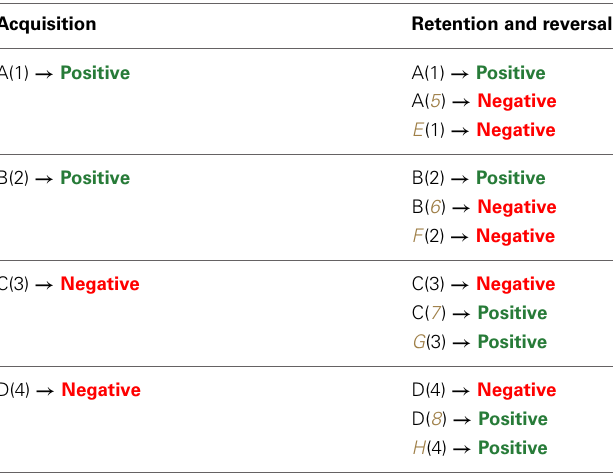
Table 3 | A schematic summary of the paradigm. Acquisition